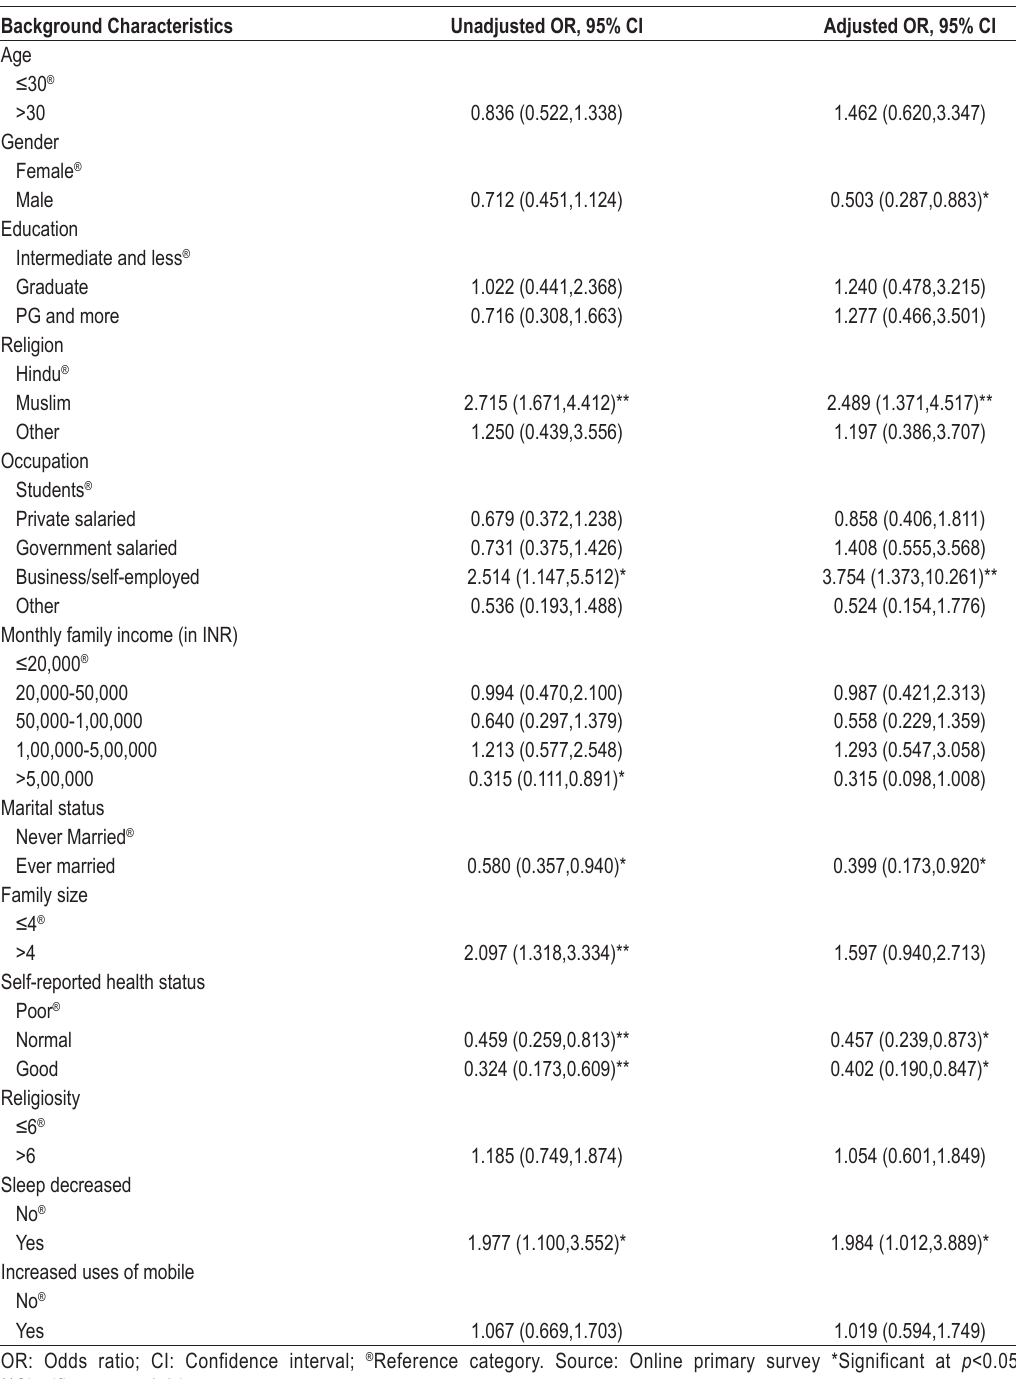
TABLE 4. Bivariate logistic regression analyses for predicting